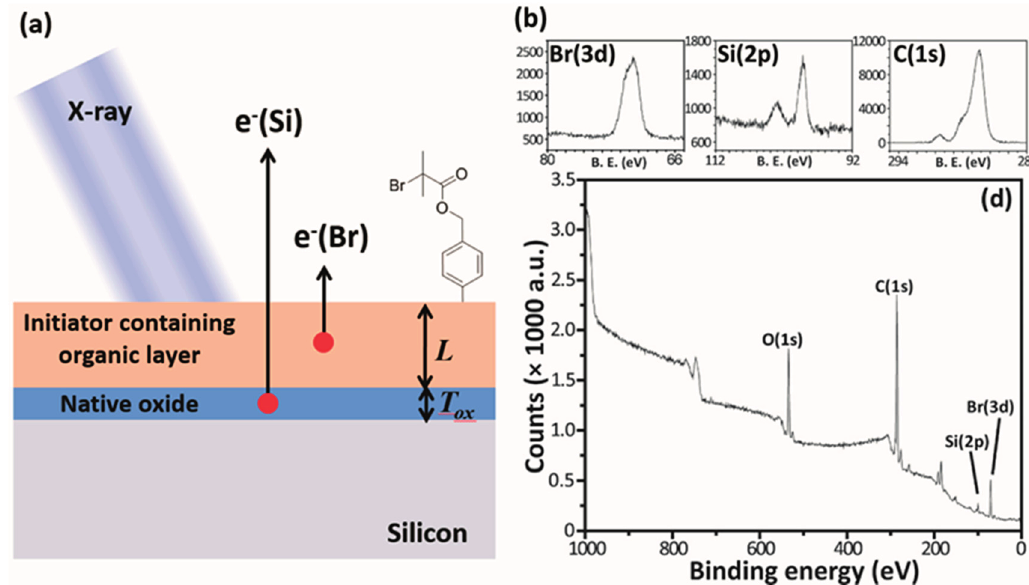
Figure 10. ( a ) XPS analysis of initiator containing organic layer on native oxide/silicon substrate; and ( b ) XPS spectra. (Reproduced with permission from Reference [106]. Copyright 2014, American Chemical